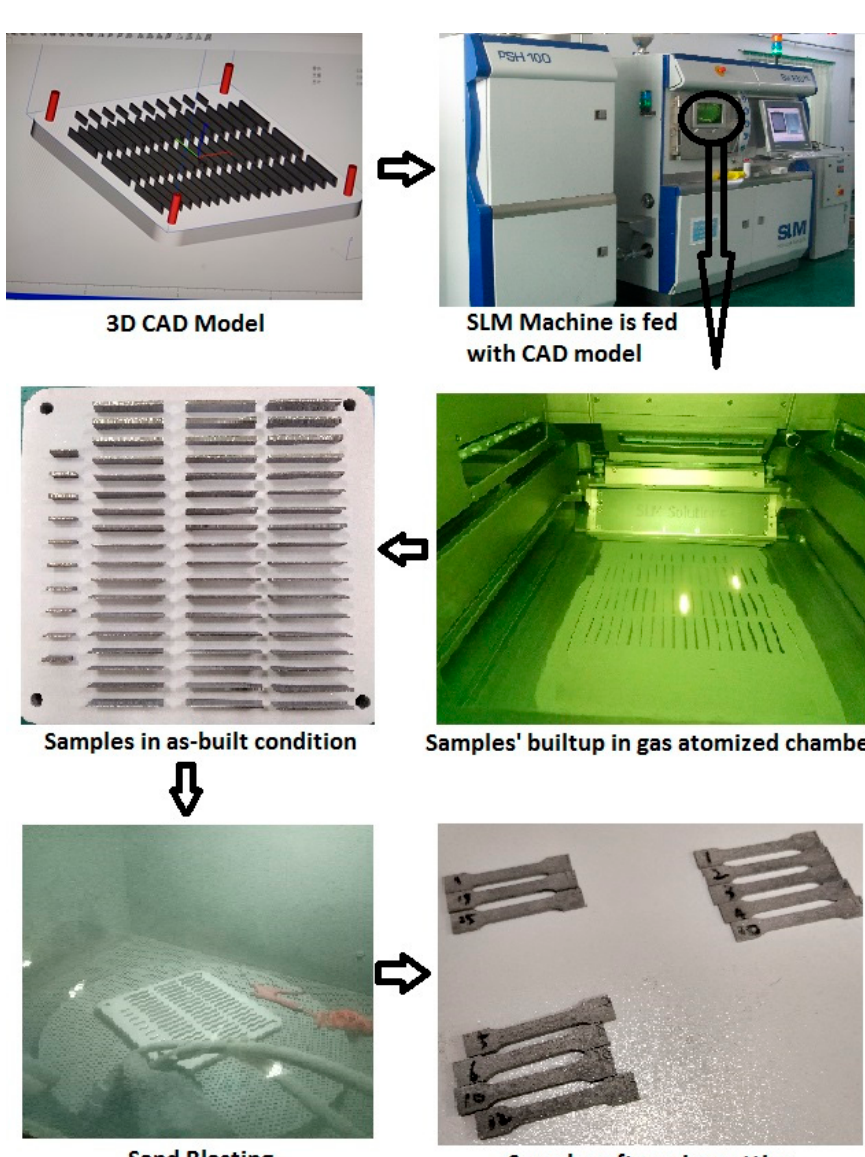
Figure 3. Dimensions of the sample after wire cutting.